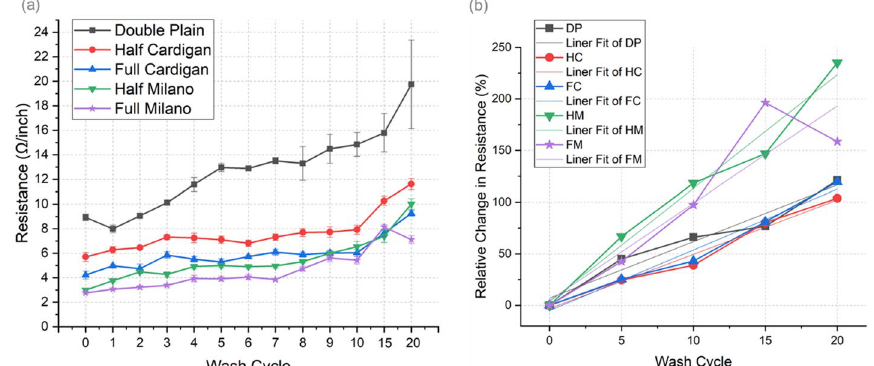
Fig. 4 a Resistance value (unit: Ω) of the weft direction of different knitted textiles before and after 1 to 10, 15 and 20 wash cycles and b relative change in resistance (%) and linear regression of weft direction in different knitted textiles after 5, 10, 15 and 20 wash cycles. Note: DP, double plain; HC, half cardigan; FC, full cardigan; HM, half Milano; FM, full